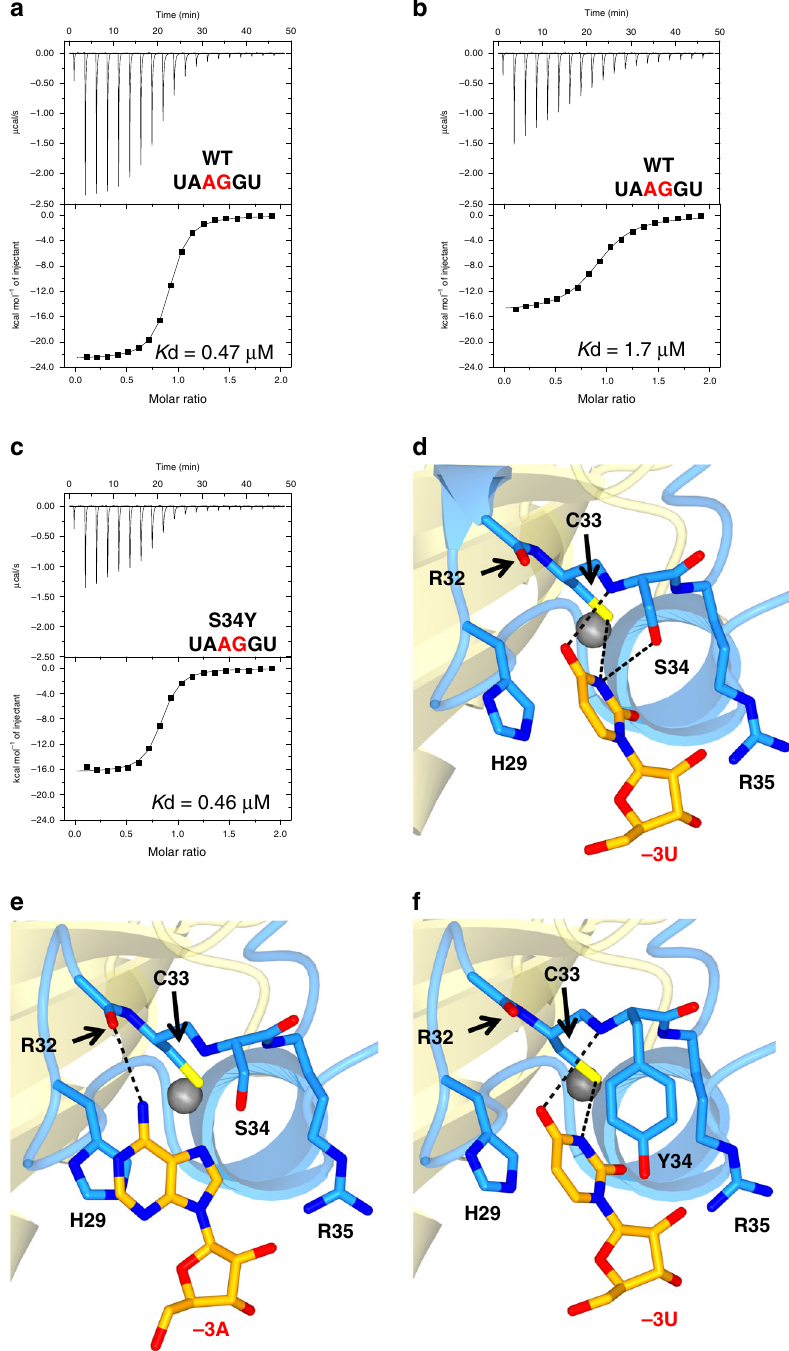
Fig. 4 Interaction of U2AF1 with the nucleotide at − 3 position. a Binding af fi nities of U2AF1 WT for the 5 ′ -UUAGGU RNA, b for the 5 ′ -UAAGGU RNA, and c S34Y for the 5 ′ -UAAGGU RNA measured by ITC. Raw data and the corresponding binding curve are depicted. Mean value for the dissociation constant ( K d ) with standard deviation is based on three independent measurements. Representative views of the interaction ( d ) between U2AF1 WT and − 3 uridine, e between U2AF1 WT and − 3 adenine, and ( f ) between U2AF1 S34Y and − 3 uridine. U2AF1 and RNA are colored as in Fig.